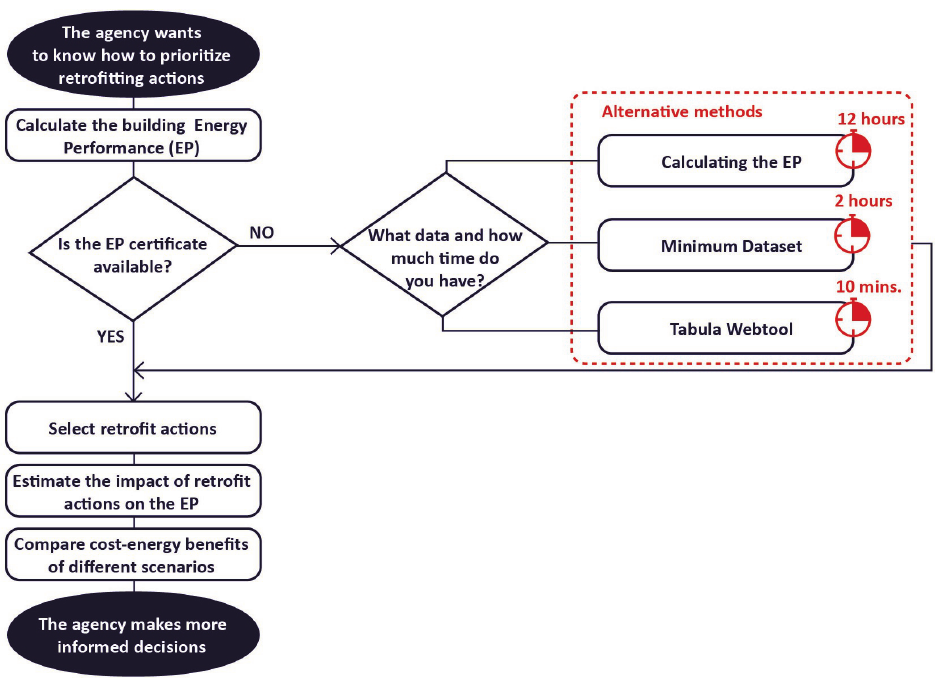
Figure 1. Implementation workflow of the